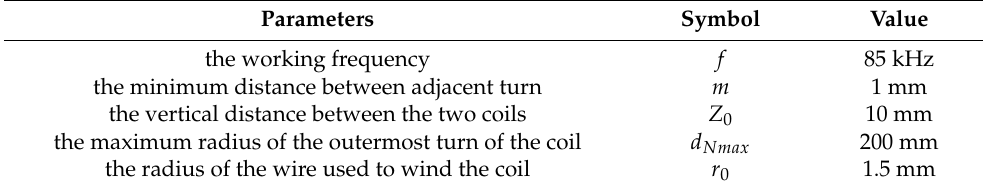
Table 1. Fixed variables. Parameters Symbol Value the working frequency f 85 kHz the minimum distance between adjacent turn m 1 mm the vertical distance between the two coils Z 0 10